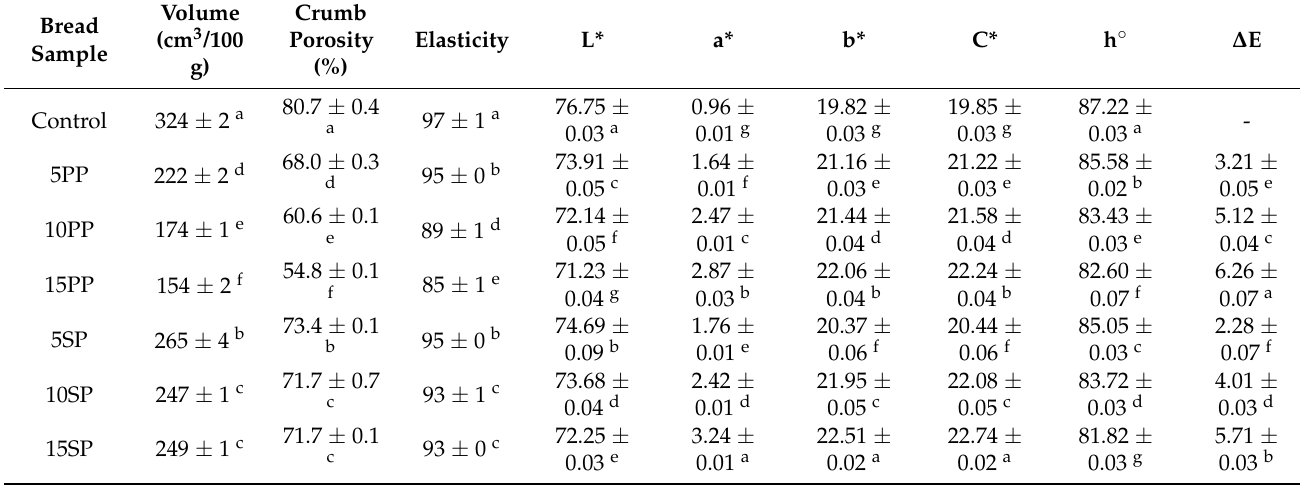
The results are mean ± standard deviation (n = 3 determinations for volume, porosity, and elasticity; n = 10 determinations for colour parameters). Values followed by different superscript letters in the same column are significantly different ( p <